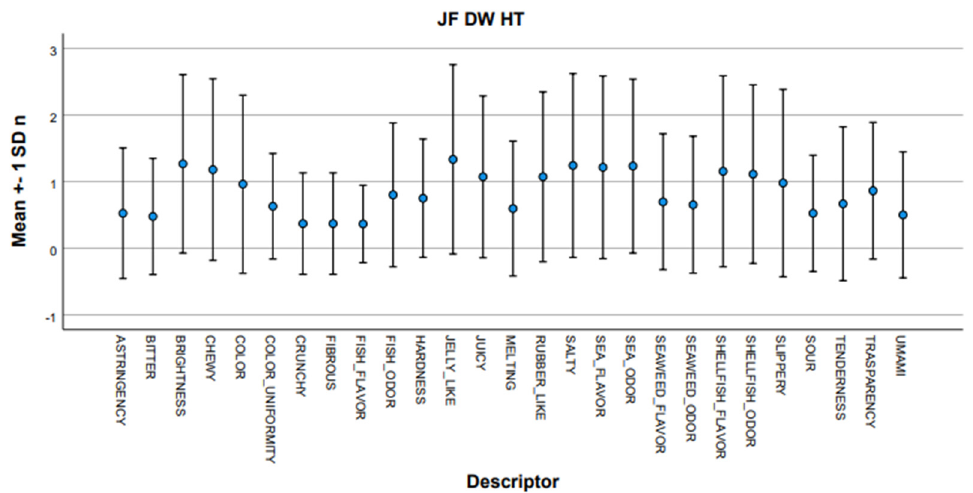
Figure 6. Error bar of the intensity mean score for descriptors selected for sample JF-DW-HT. Bars represent standard deviation.